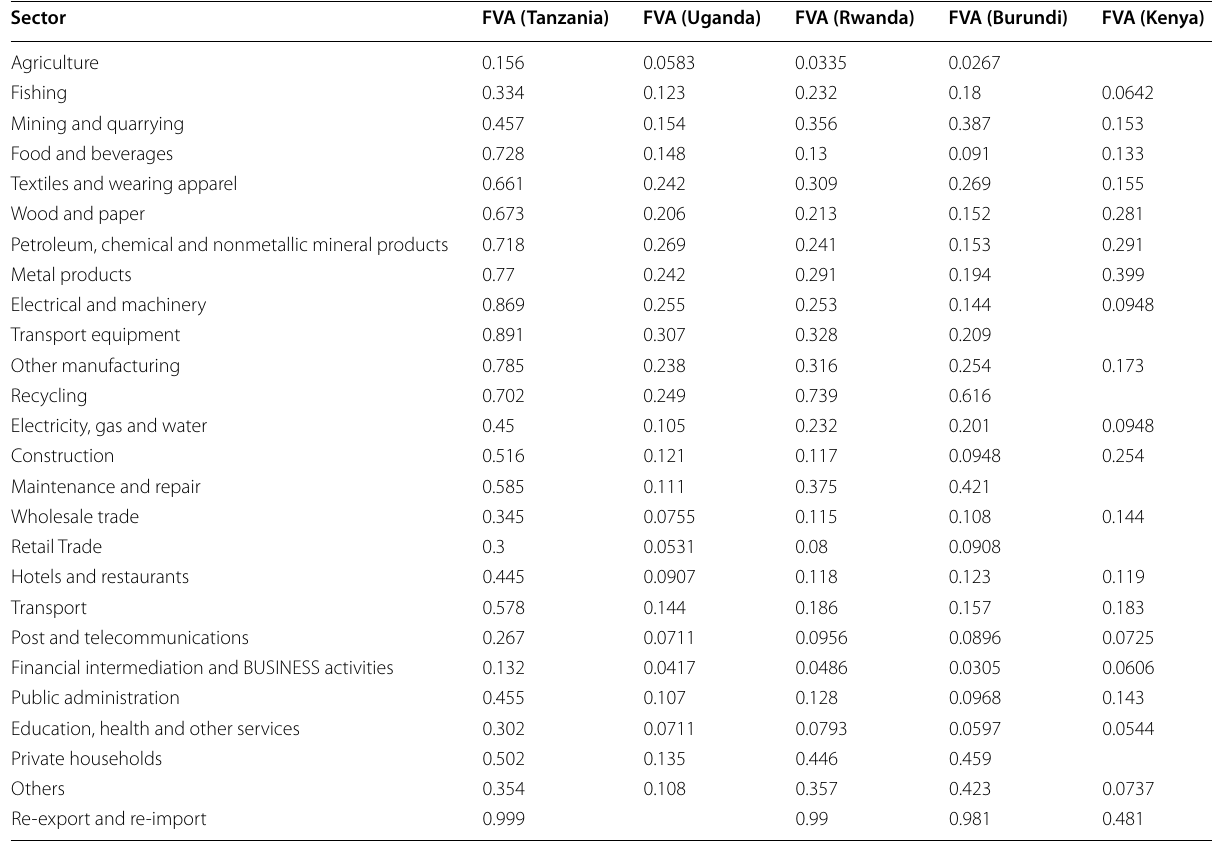
Table 2 Foreign value added (FVA) for selected EAC countries